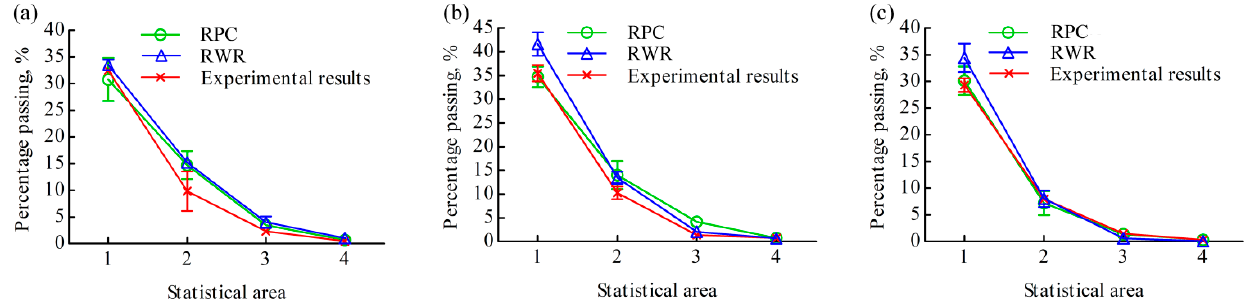
Figure 18. Comparisons between the experimental results and the simulation results in terms of percentage passing of different statistical areas passing for three varieties: ( a ) Liangyu99, ( b ) Xianyu 335, and ( c ) Zhengda 999.